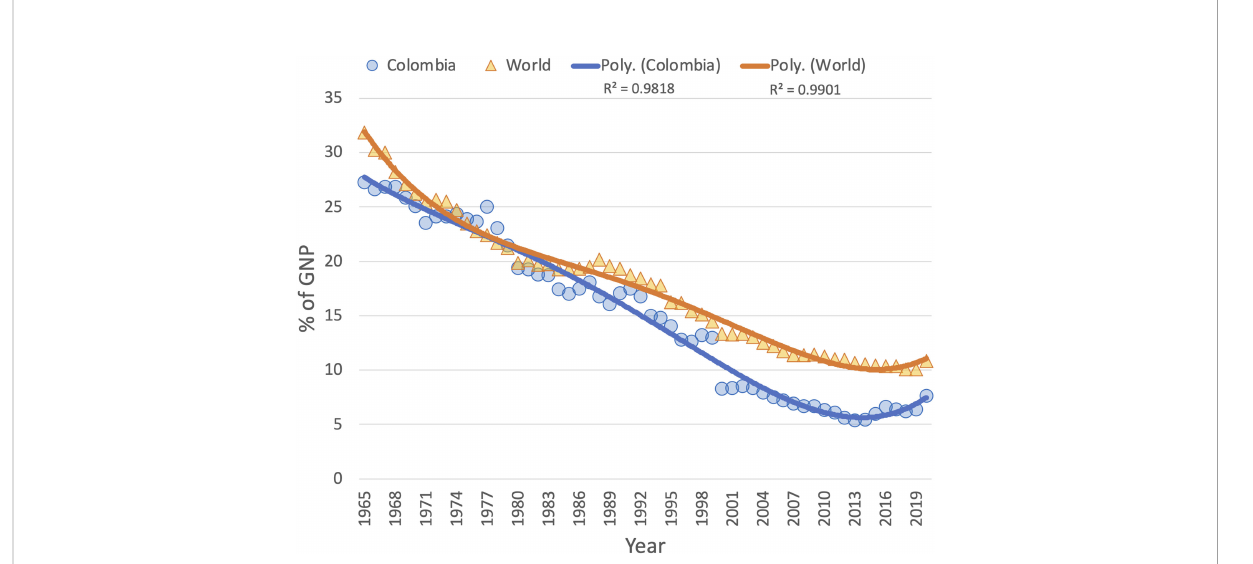
FIGURE 2 Agricultural sector contribution to Colombia ’ s and World ’ s GNP shows a steady decline (faster for the former) in percent contribution since 1965. Includes forestry, hunting and fi shing, in addition to growing crops and raising animals. Value added is the net production of the sector, after adding all the products and subtracting the intermediate inputs. It is calculated without making deductions for depreciation of manufactured goods or for depletion and degradation of natural resources. For the countries that count on a value added basis, including Colombia, the gross value added at factor cost is used as the denominator. Source: World Bank National Accounts Data and OECD National Accounts Data